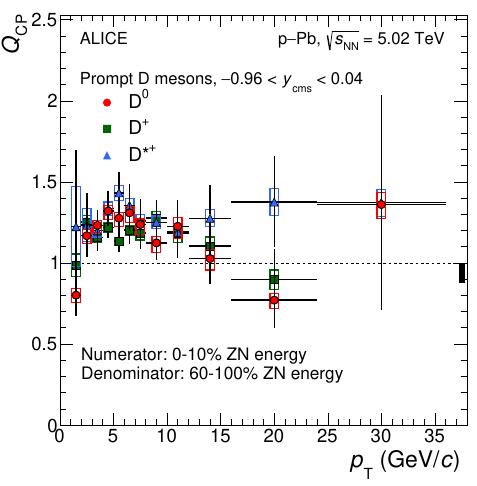
Figure 16 . D 0 , D + , and D (cid:3) + meson Q CP , obtained using 0{10% as the central class and 60{100% as the peripheral class. The vertical bars and the empty boxes represent the statistical and sys- tematic uncertainties, respectively. The colour-(cid:12)lled boxes at Q CP = 1 represent the normalisation